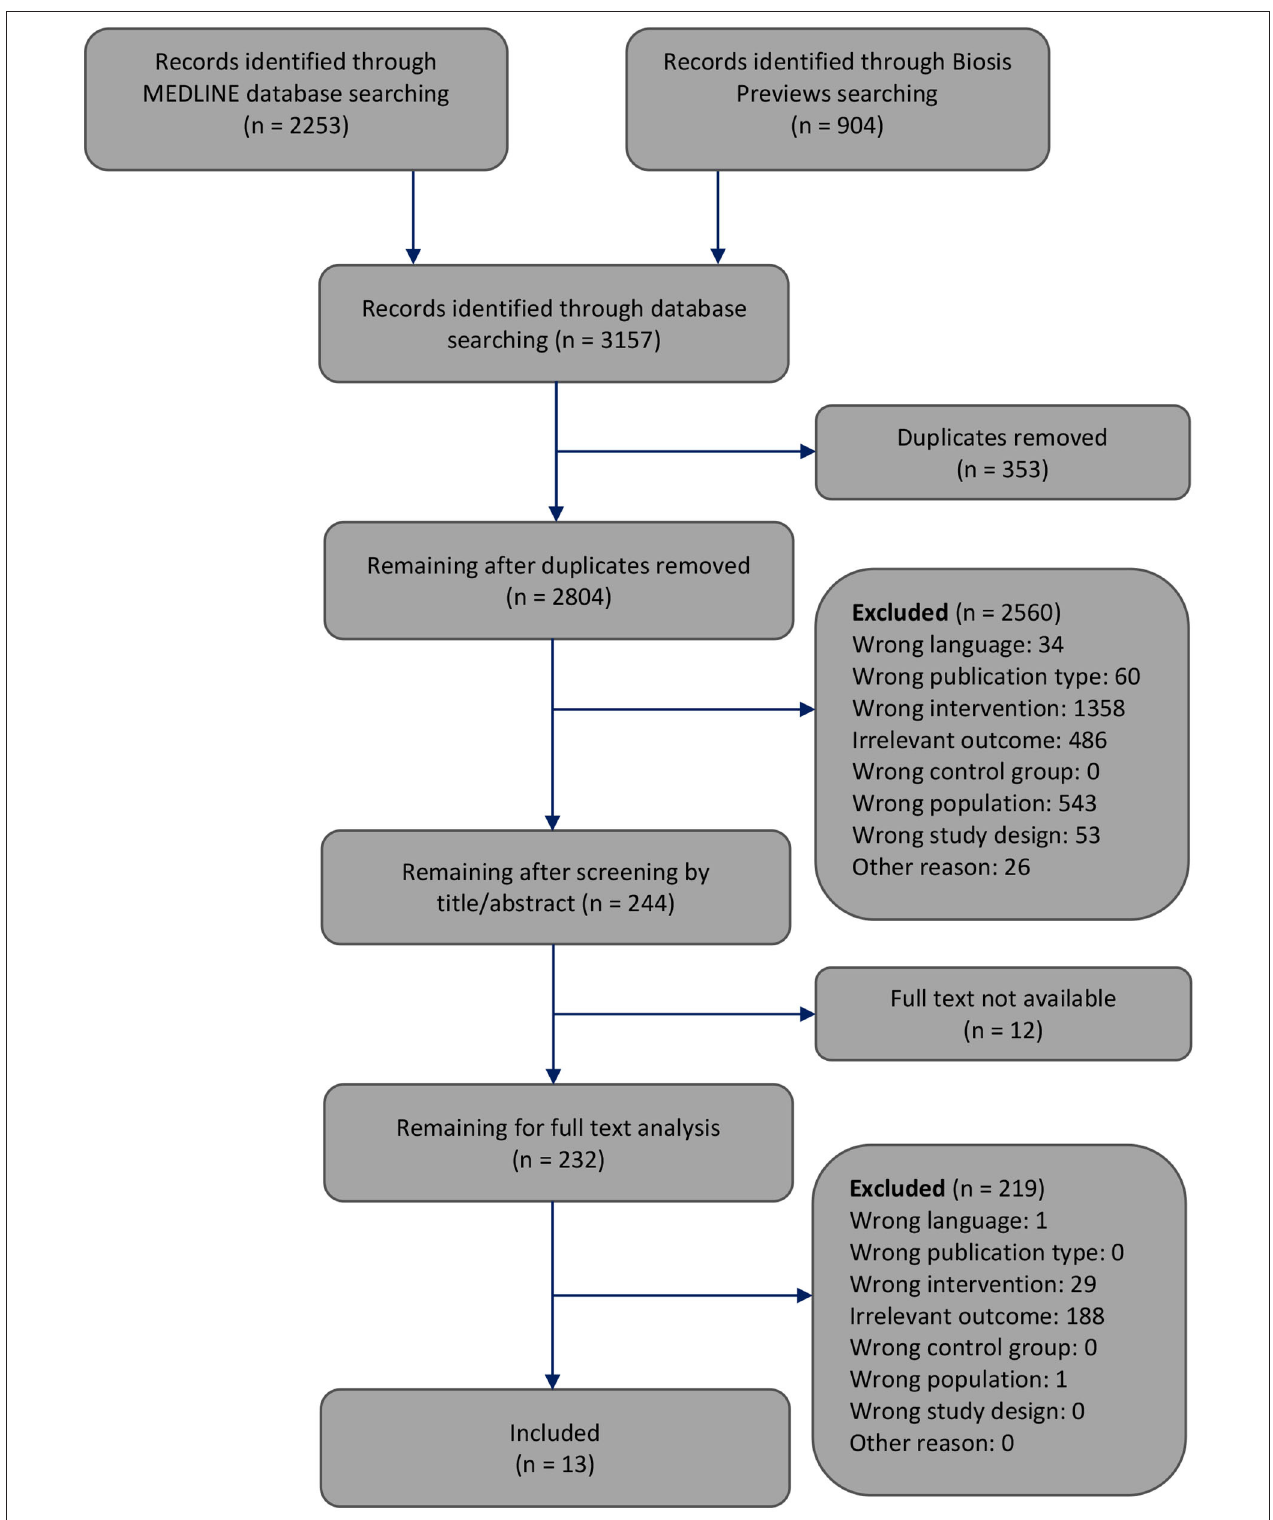
FIGURE 1 | Flowchart through different phases of the systematic review modified according to Moher’s publication (Moher et al., 2009).